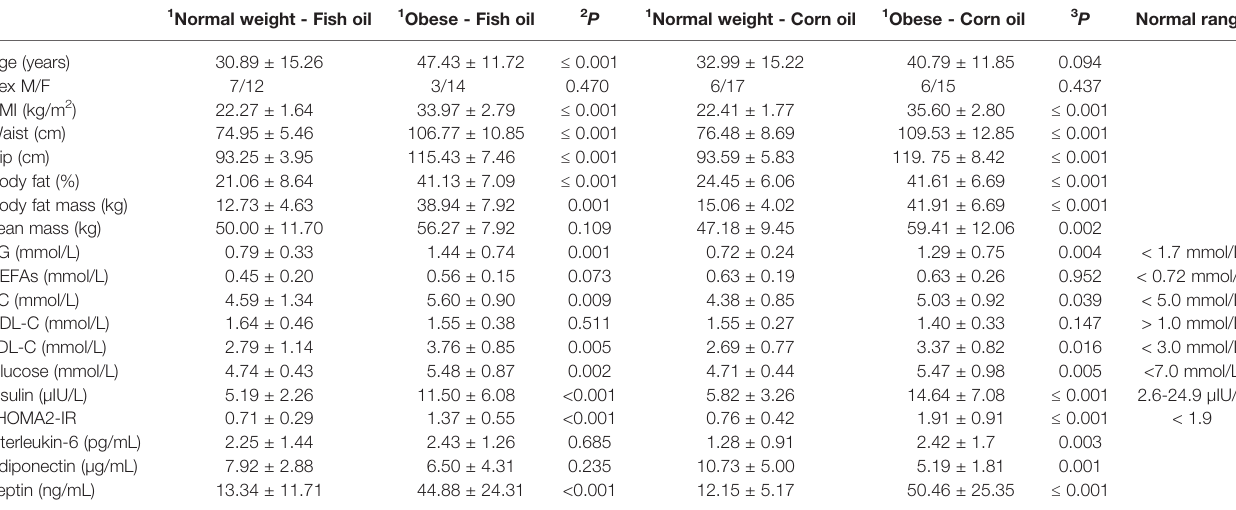
TABLE 1 | Anthropometric and metabolic characteristics in normal weight and individuals living with